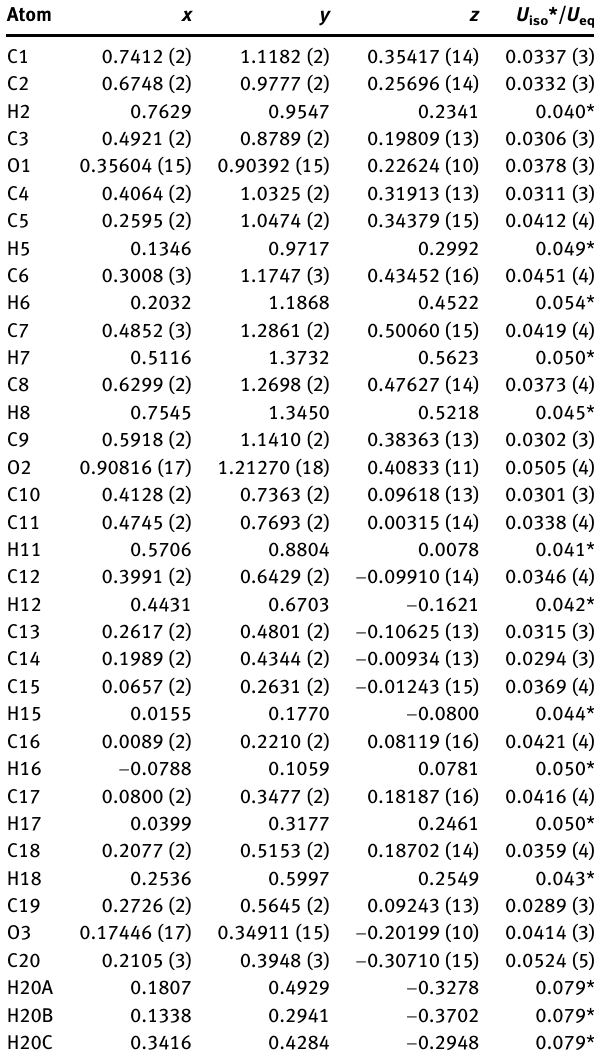
Table  : Fractional atomic coordinates and isotropic or equivalent isotropic displacement parameters (Å 